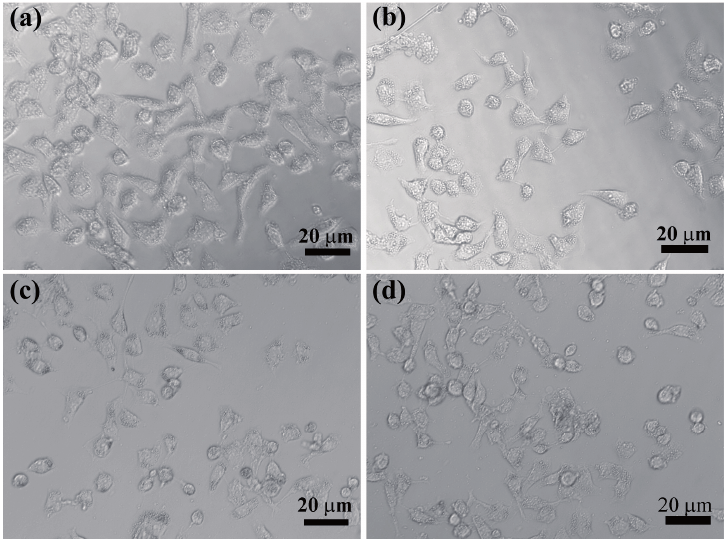
Figure 8. Phase contrast photomicrographs of KB cells treated with ( a ) PBS, ( b ) LM-G2, ( c ) free DOX, and ( d ) LM-G2/DOX at a DOX concentration of 0.2 μM for 24